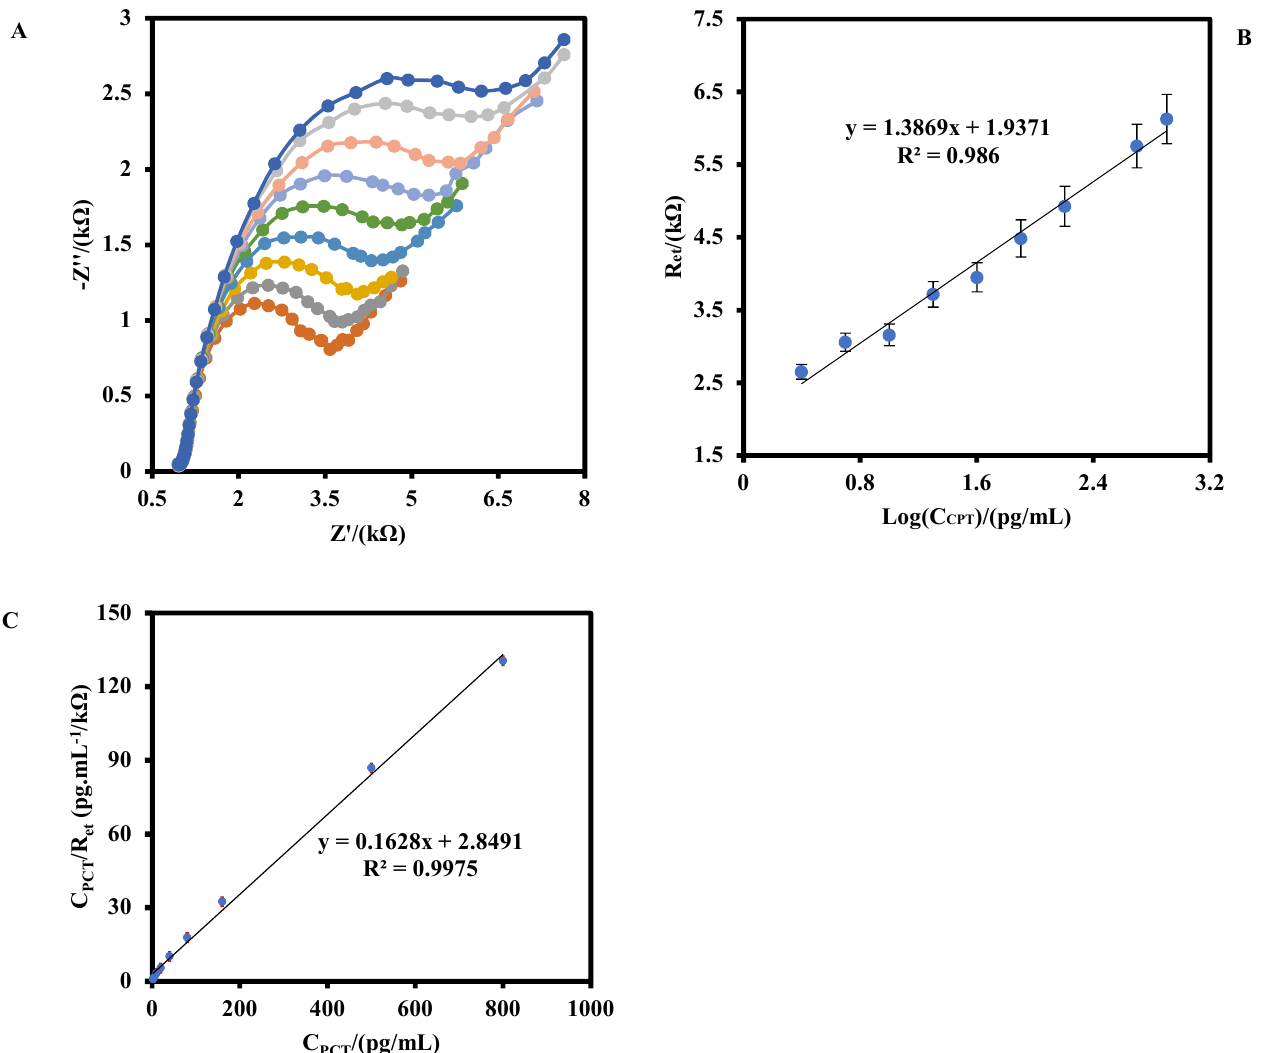
Figure 5. ( A ) EIS response of IDGE/Au nano /3-MPA/Anti-PCT/BSA at the optimum operating condi- tions for different of PCT concentrations (2.5, 5.0, 10.0, 20.0, 40.0, 80.0, 160.0, 500.0, and 800.0 pg/mL). ( B ) The corresponding linear logarithmic calibration plot of the immunosensor. ( C ) The plat of Langmuir binding isotherm model for IDGE/Au nano /3-MPA/Anti-PCT/BSA. The error bars were related to the five different